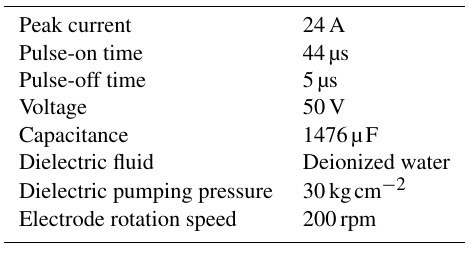
Table 1. Chemical composition (in wt%) of stainless steel 304. Table 2. Drilling parameters.